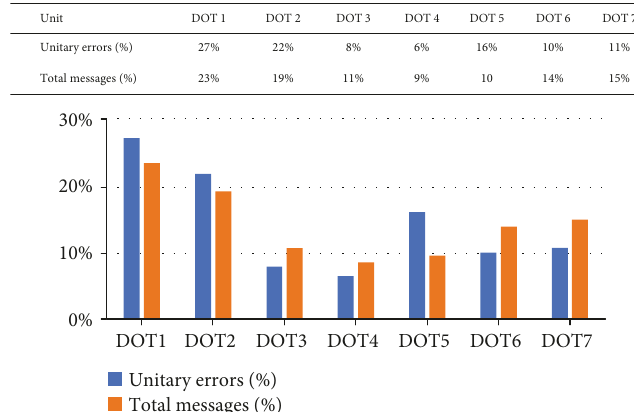
Figure 4: Total messages sent by unit and its committed errors.